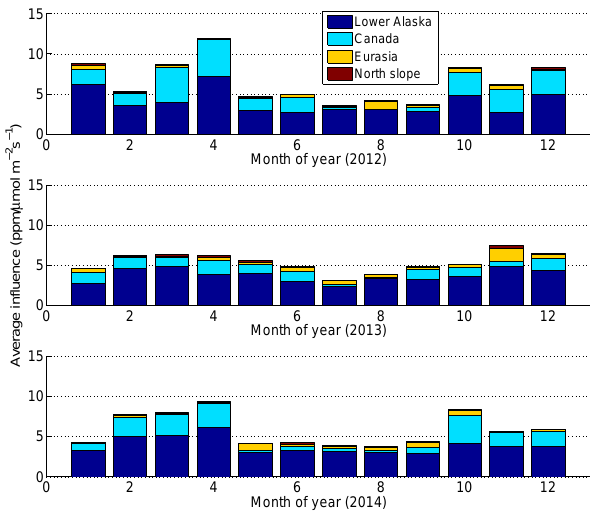
Figure 2. Mean monthly diurnal cycle amplitude of hourly averaged CO 2 (top) and CH 4 (bottom). The average over 3 full calendar years (2012–2014) is shown in black with the gray shading indicating 1 standard deviation of each month’s average. The average diurnal cycles for each individual year are indicated by the blue (2012), green (2013), and red (2014) solid lines.